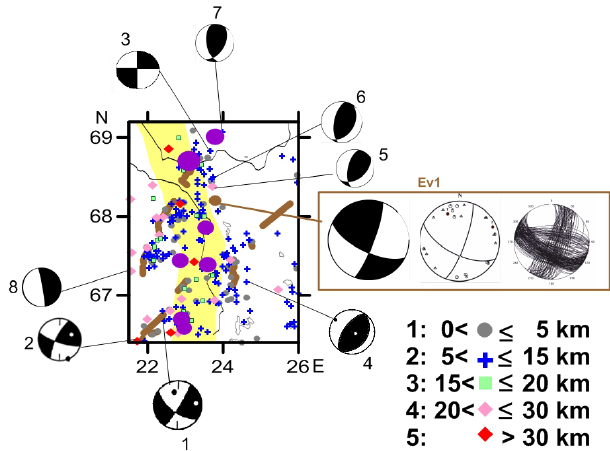
Figure 5. Local earthquakes from catalogue FENCAT in the pe- riod with 1964 to 2008 years and available fault plane solutions for some earthquakes in the Region 2. The earthquakes are divided into five groups depending on hypocentre depth. The number of earth- quakes equals 55 in Group 1, 126 in Group 2, 17 in Group 3, 21 in Group 4, and 5 in Group 5. Deep earthquakes with reliable lo- cation from Table 3 are shown by purple circles. Event for which we calculated focal mechanism (Table 4) is indicated by brown cir- cles. In the brown frame left: lower hemisphere equal area projec- tions of the focal sphere, middle: octagons and triangles represent compressions and dilatations, right: the set of 150 acceptable mech- anisms for demonstration of uncertainty range. Brown lines are de- noting postglacial faults. Baltic-Bothnia Megashear (BBMS) from (Berthelsen and Marker, 1986) is shown by yellow